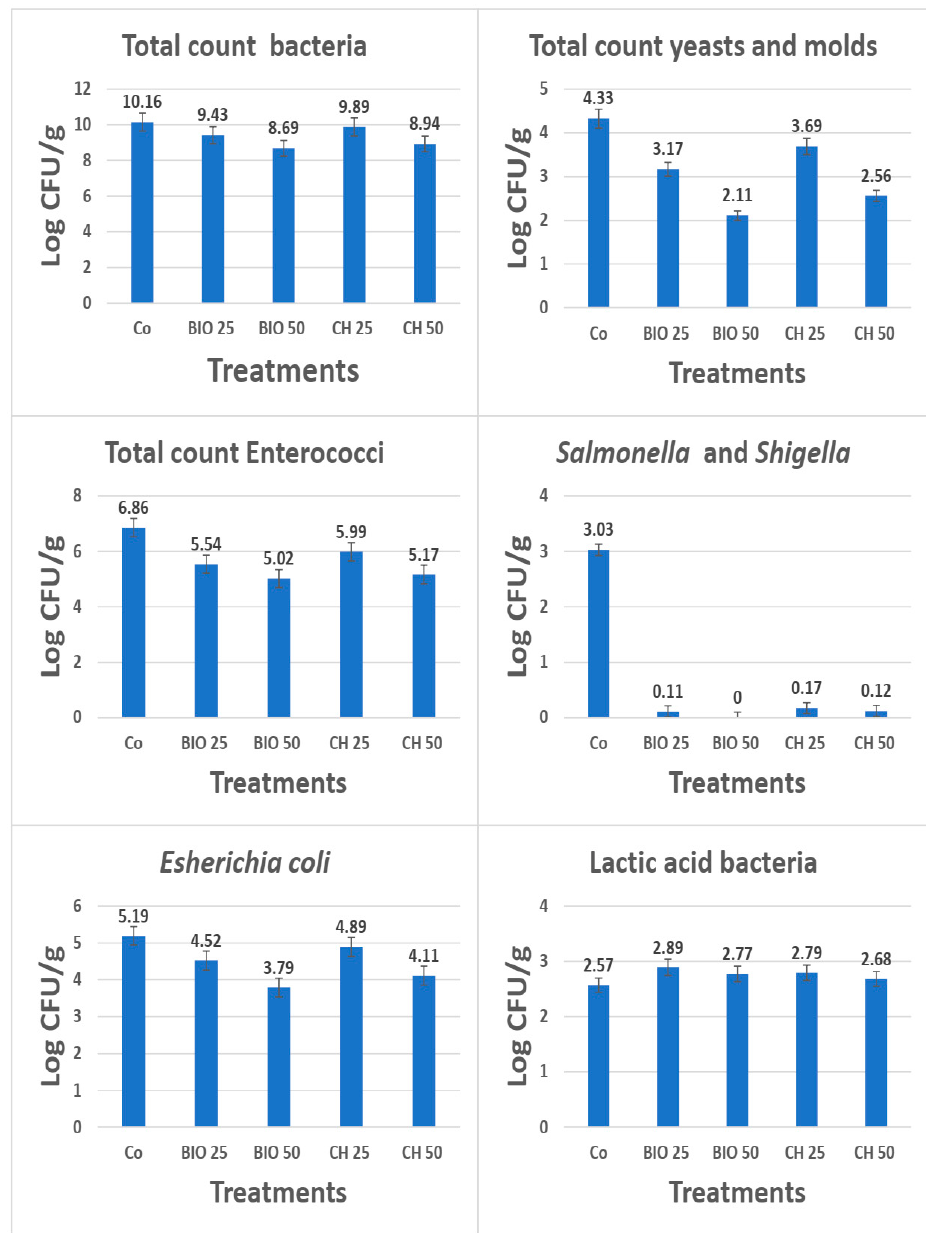
Figure 2. Changes in bacterial count (log cfu/g) determined in cecum of rabbit.